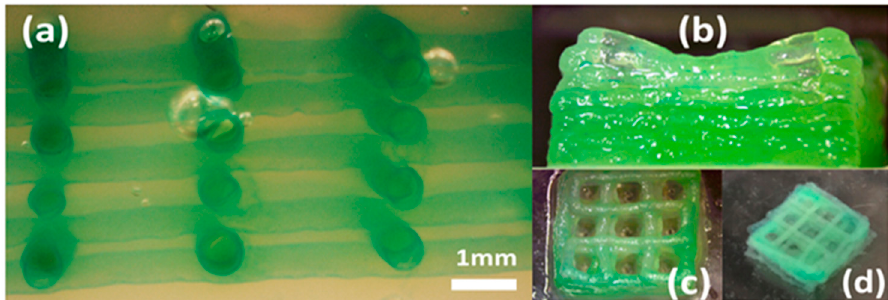
Figure 8. Mesh scaffold printing with weak interfacial connections: ( a ) The cross section of the printed structure before removal of the support bath; ( b ) side view of the printed mesh structure after removal of support bath; ( c ) top view of the printed mesh structure after removal of support bath; ( d ) unraveling of the layered structure within CaCl 2 bath due to the disturbance caused by shaking the petri-dish.